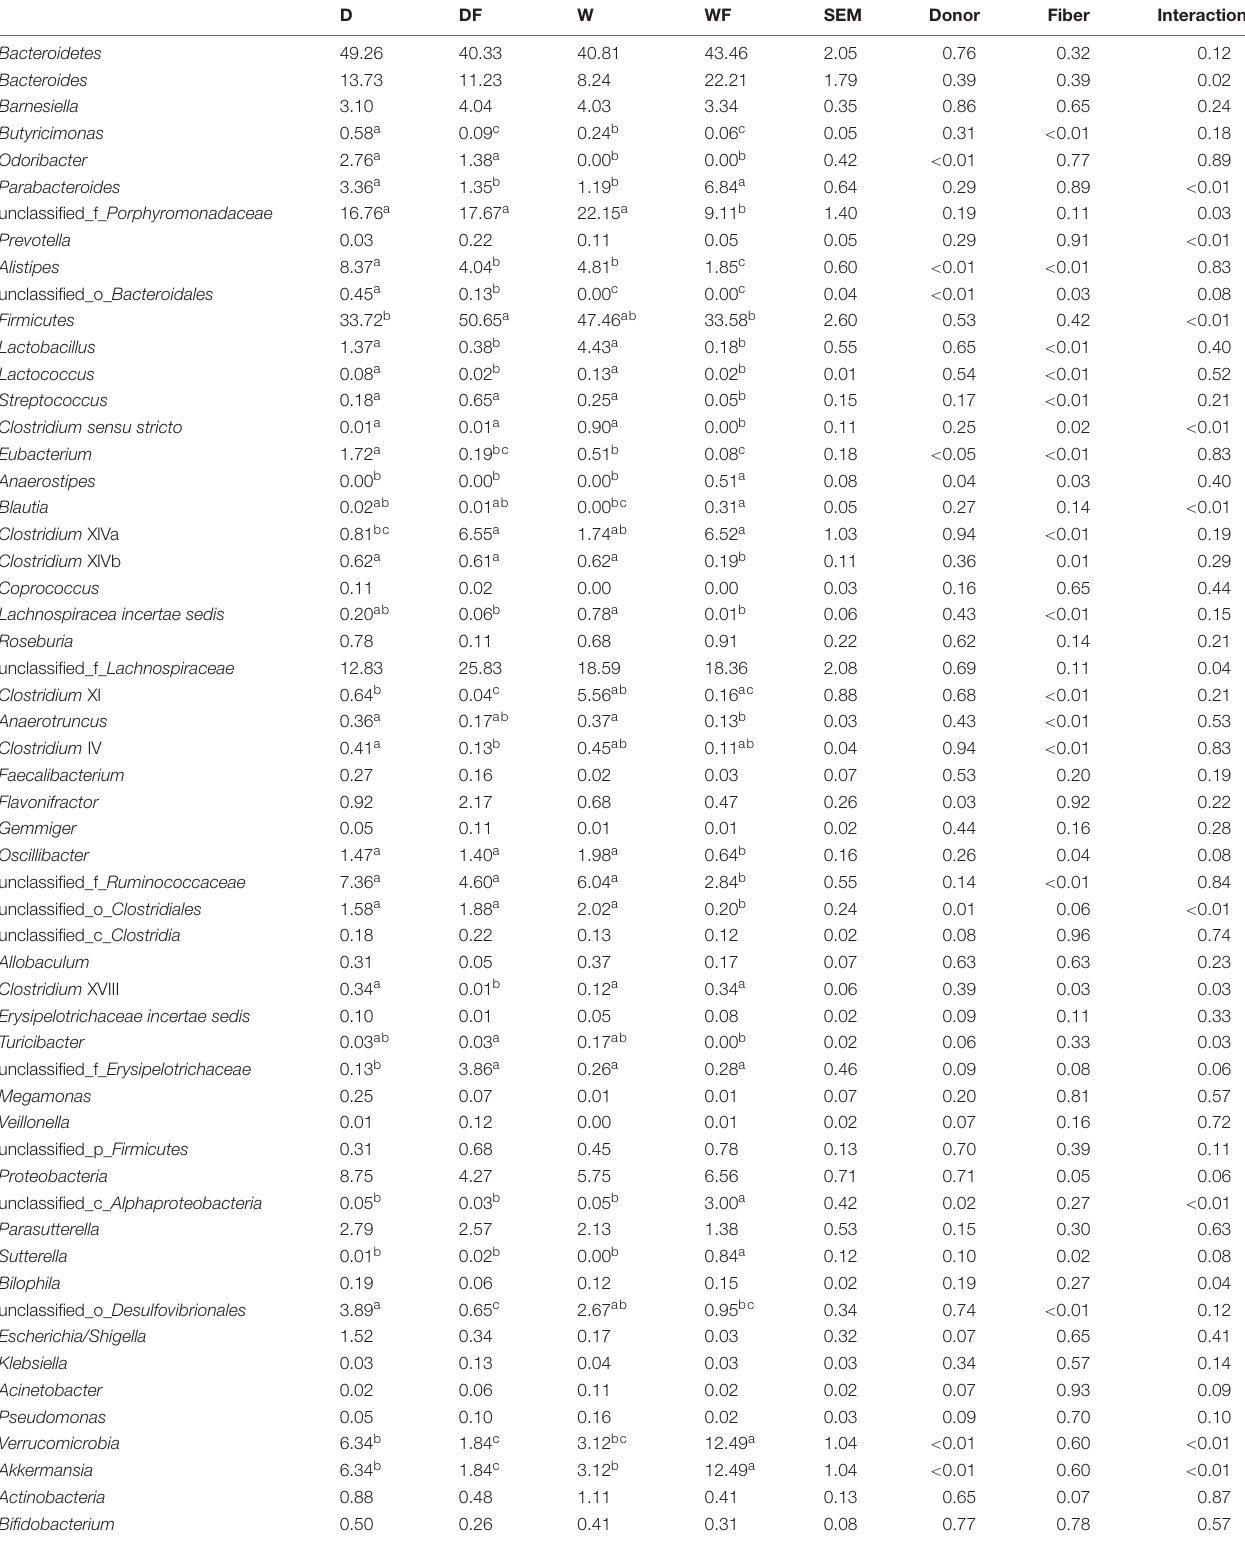
TABLE 1 | Relative abundance of differential gut microbiota at genus level ( > 0.1%) between mice transplanted domestic pig fecal bacteria and feed a low-fiber diet (D) or high-fiber diet (DF), transplanted wild boar fecal bacteria and feed low-fiber diet (W) or high-fiber diet